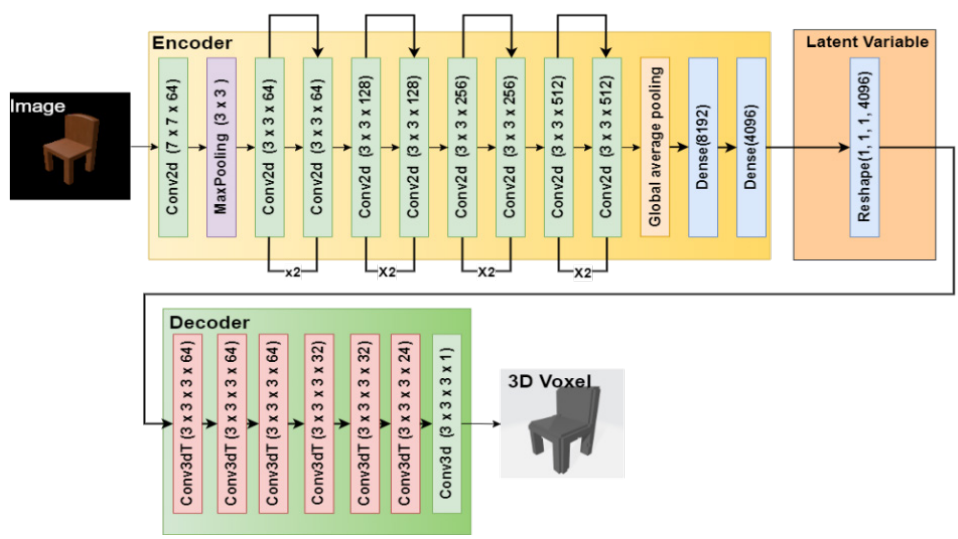
Figure 3. Structure of VoxGen with the modified-ResNet18 encoder. It is worth mentioning that the original VGG16 has three fully connected layers; their sizes are 1 × 4096, 1 × 4096, and 1 × 1000. By contrast, the original ResNet18, 34, and 50 have a global average pooling layer and one 1 × 1000 fully connected layer. Based on our experiments, the depth and width of the fully connected network of the original VGG16 and ResNet were not suitable to achieve sufficient accuracy of the generated 3D voxel models. Consequently, we increased the depth and width of the fully connected networks in the VGG16-encoder and ResNet18, 34, 50-modified encoders. Moreover, the flattened layer of the original VGG16 is fully flattened, while that of the original ResNet 18, 34, and 50 is a global average pooling layer, as shown in Figure 4. Generally speaking, fully flattened layers are useful for improving the accuracy of generated 3D voxel models, as they retain all of the extracted features; however, they require massive data computation if the number of feature maps is large. Conversely, the global average pooling layer helps save on the computation cost of the neural network but may also degrade the accuracy